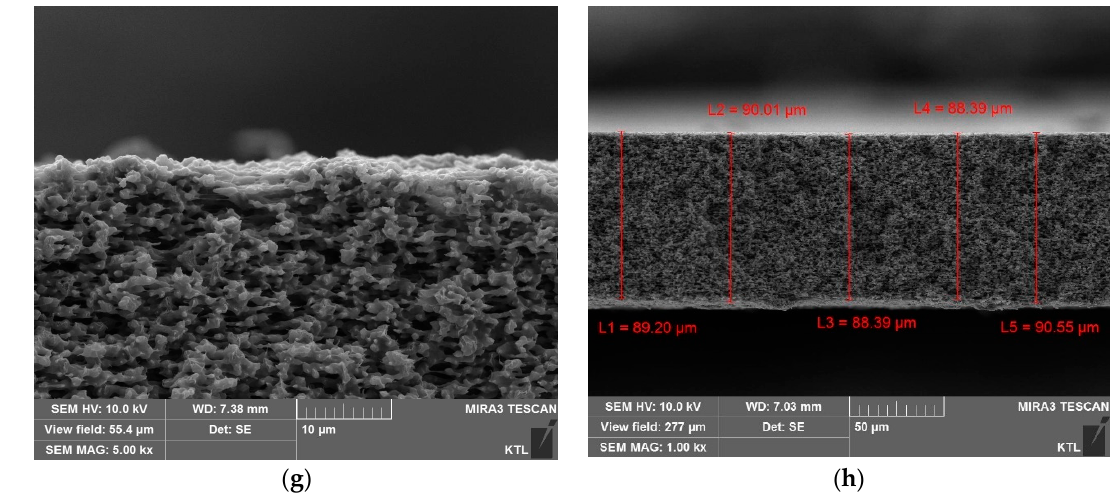
Figure 5. Scanning electron microscope (SEM) images for cross-sections of different polyvinylidene fluoride (PVDF) membranes. The labels ( a ), ( b ) are HVHP and ( e ), ( f ) are GVHP membranes without pressure, respectively. The labels ( c ), ( d ) are pressurized HVHP and ( g ), ( h ) are GVHP membranes at different pressure 30 kPa.